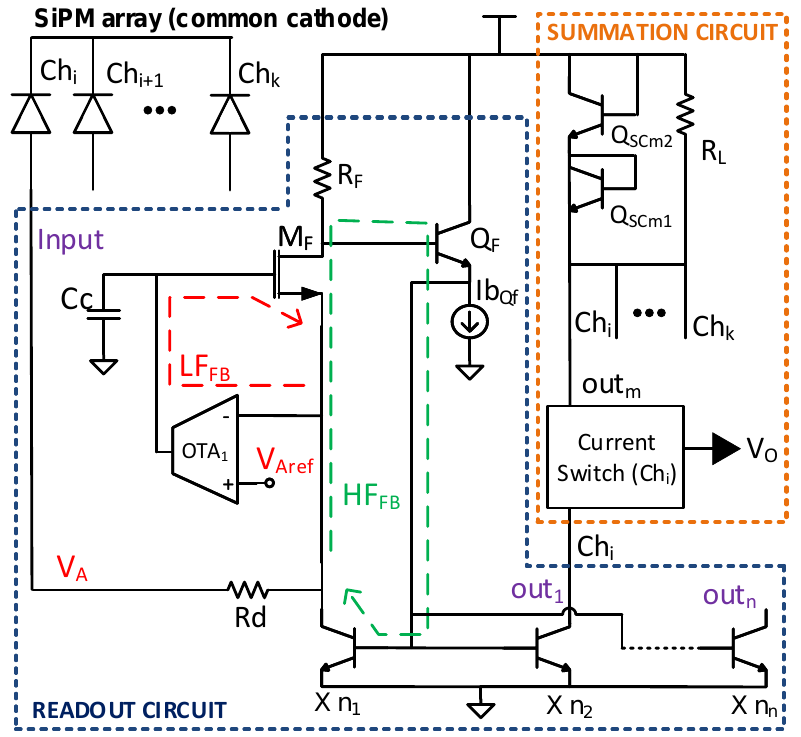
Figure 2. Input current stage including the readout circuit and the summation block. The current division scheme splits the input current into differently scaled copies. These signals are connected to independent current mirrors to implement the different features described in Section 2.1. The main characteristics of the input stage block are detailed